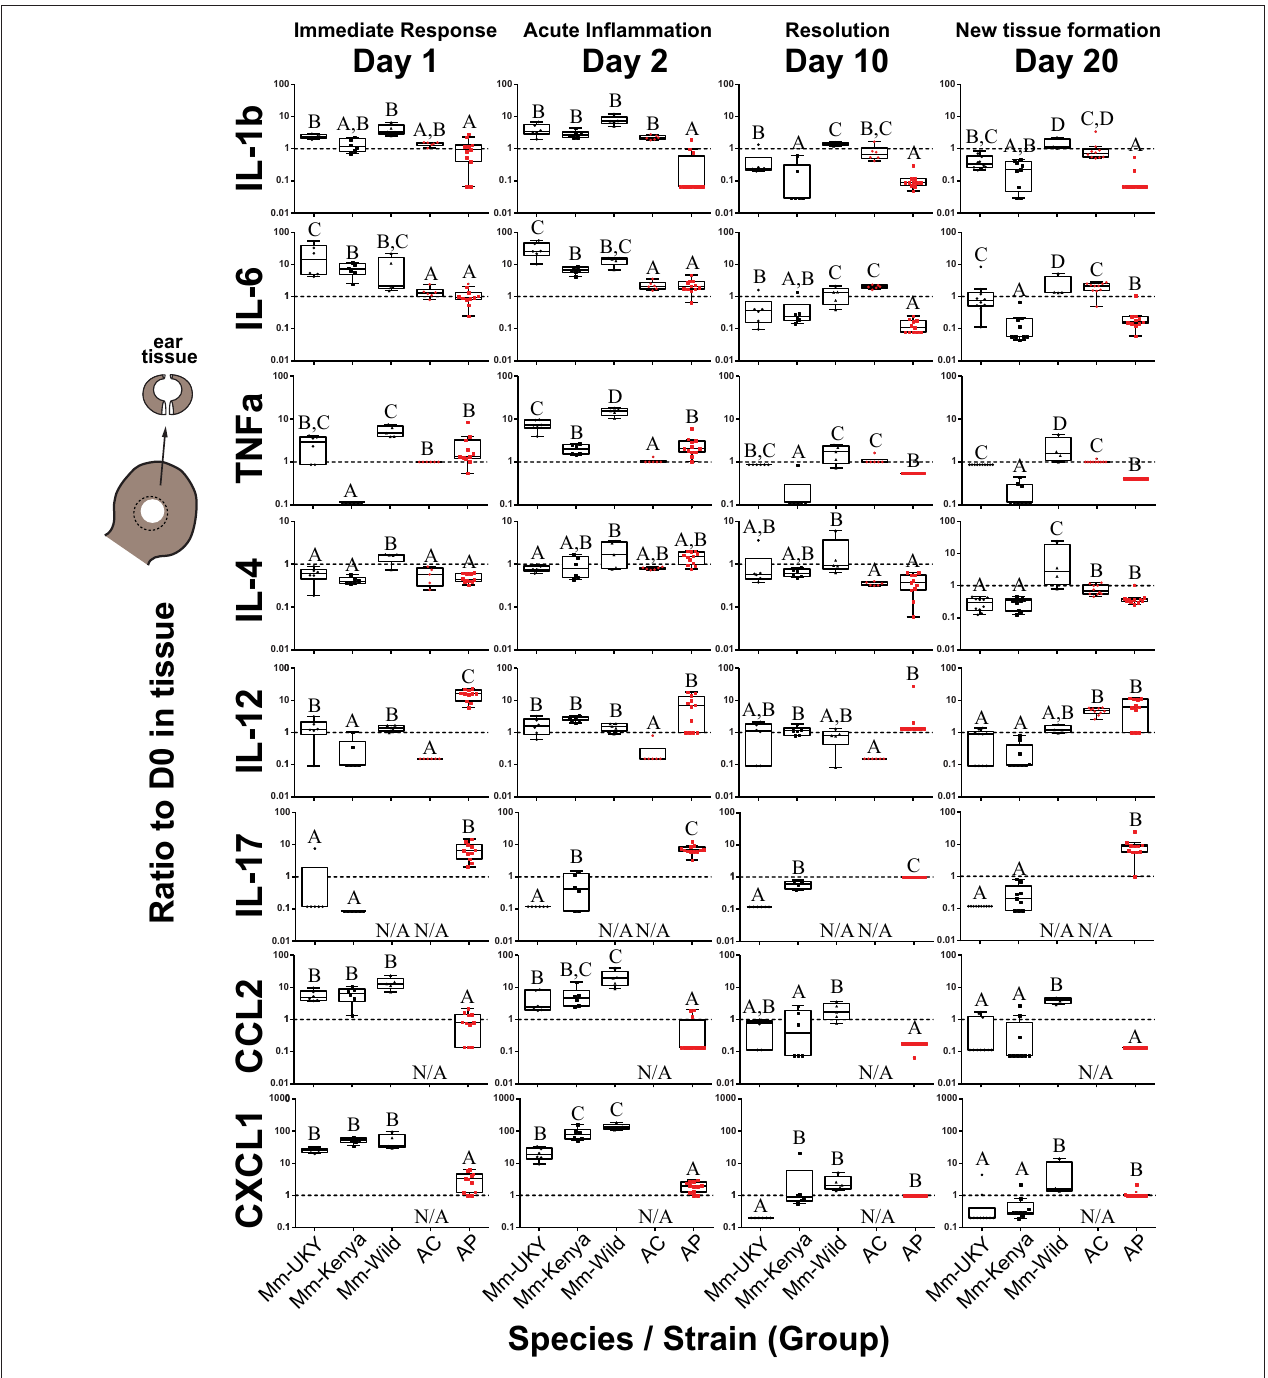
FIGURE 3 | Injury-induced cytokine concentrations are dynamic in the tissue microenvironment with acute increases in IL-6, CCL2 and CXCL1 strongest in non-regenerating animals. Cytokine ratios present in tissue lysate relative to D0 at D1, 2, 10, and 20 days post ear punch injury. Non-regenerators (Mm-UKY, Mm-Kenya, and Mm-Wild: Black) show a stronger response compared to regenerators (Ac and Ap: Red) for IL-6, CCL2, and CXCL1 during the acute inflammatory phase. These differences mostly resolved by D10. In contrast, regenerators showed a stronger IL-12 and IL-17 response during tissue morphogenesis. Data represent box and whiskers with median, interquartile range and individual data points. N/A denotes concentrations could not be quantified. The dashed line at Y no change compared to D0. Each graph showed P < 0.05 for a group effect using a One-way ANOVA on log-transformed data (See Table S5 ) and different letters above each group denotes P < 0.05 for Tukey-Kramer pairwise comparisons (See Data File S1 ).